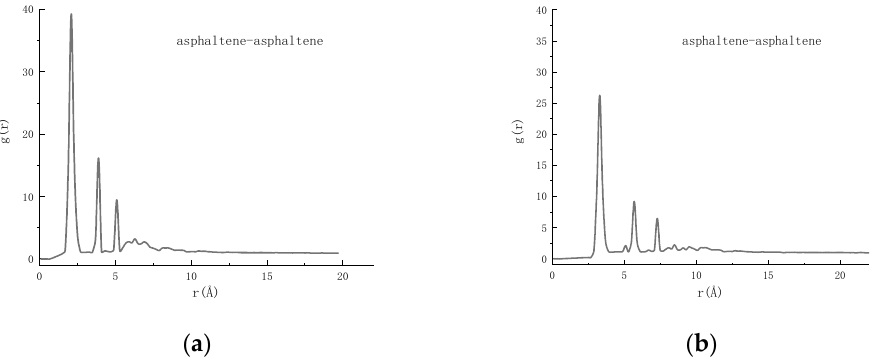
Figure 10. RDF curves of asphaltene pairs ( a ) asphaltene model oil ( b ) asphaltene with biodiesel oil.